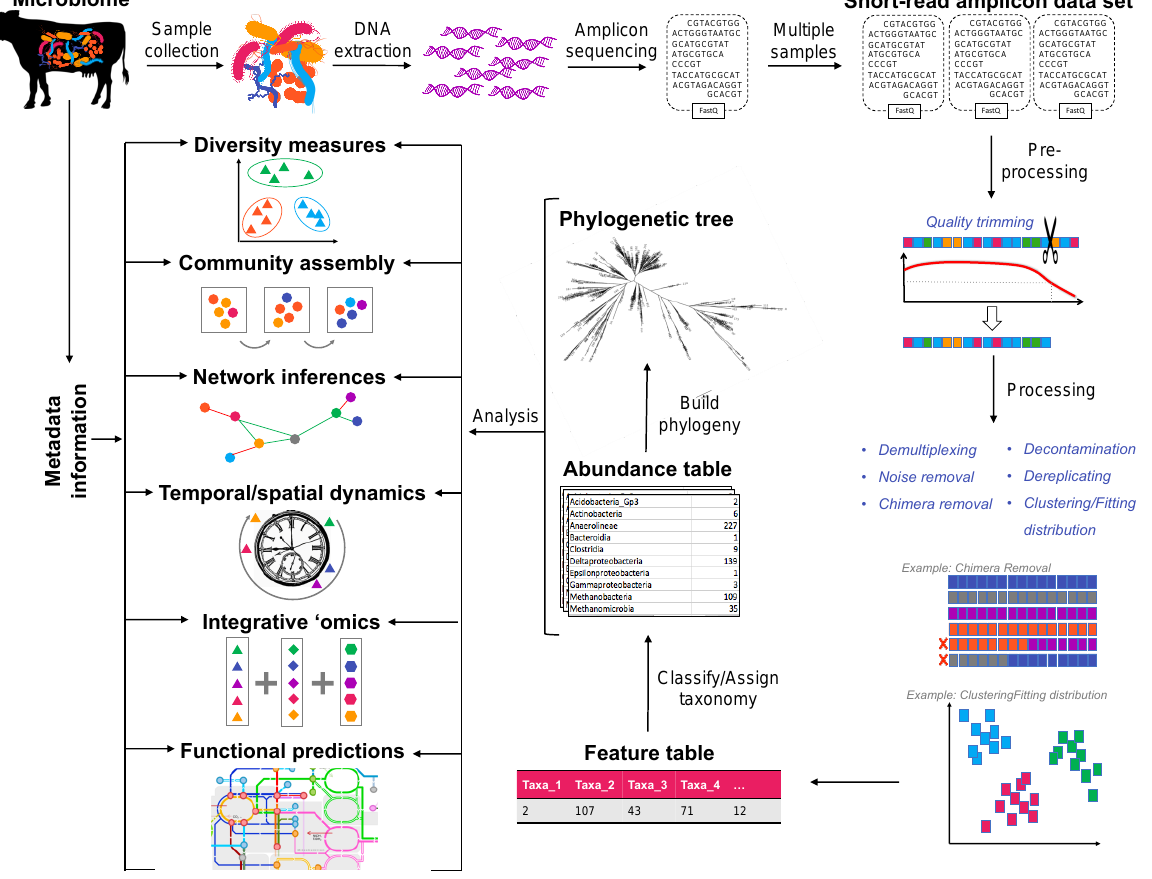
Figure 1. Summary of amplicon sequencing workflow. Basic diversity analysis are only a small fraction of available types of analyses available for microbiome analysis.